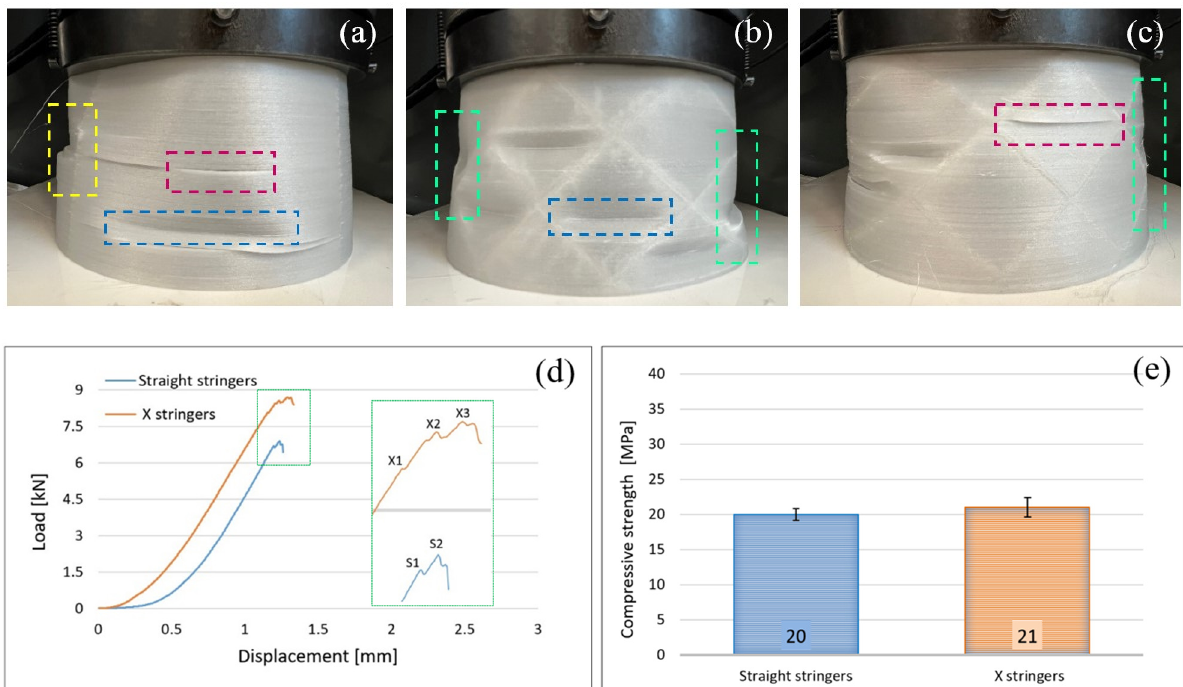
Figure 6. Compression tests of UAV fuselage sections. Fuselage section with straight ( a ) and X stringers ( b ), ( c ), respectively during compression tests; ( d ) load-displacement curves; ( e ) compression strength of straight and X stringers.